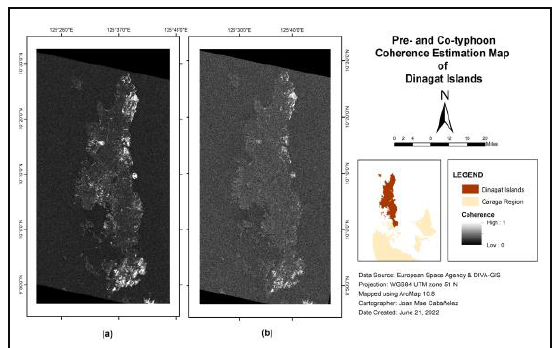
Figure 5 . Pre-typhoon and Co-typhoon Coherence map of Dinagat Islands